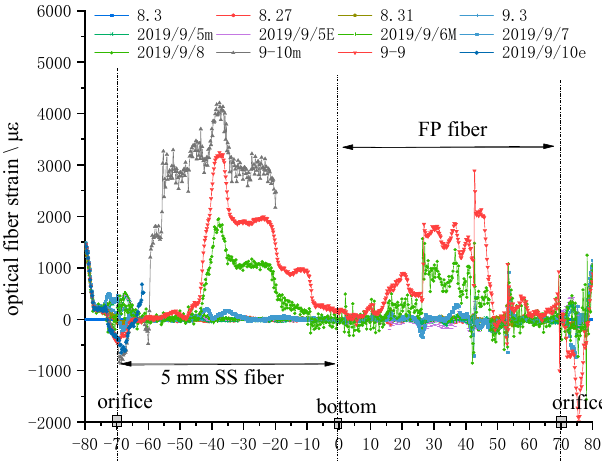
Figure 25. Strain of optical fiber from steel strand to fixed-point optical cable of line ① .